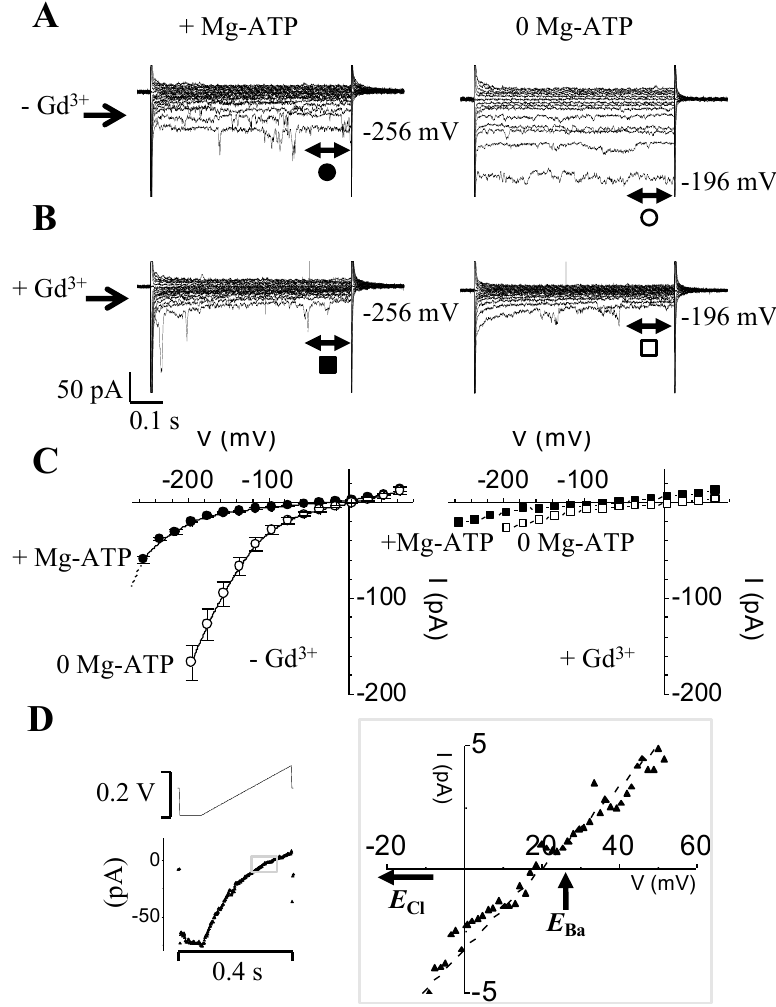
Figure 1. Removal of intracellular Mg-ATP unveils a larger instantaneously-activated, inwardly-directed, and Gd 3 + -sensitive Ba 2 + current. ( A ) Typical examples of current traces in whole-cell mode obtained from two separate V. faba guard cells with the pipette solution either containing (left traces) or lacking (right traces) Mg-ATP (1 mM). The pulse protocol mostly used throughout this study consisted of 0.6 s long square voltage pulses ranging from + 64 to − 256 mV in − 20 mV increments; the holding potential h v was set to − 36 mV. In order to preserve the quality of the “giga” seals, guard cell protoplasts (GCPs) with no Mg-ATP in the pipette were not subjected to higher voltages beyond − 196 mV. ( B ) Current ( I ) traces of I Ba obtained from the same cells and in the same conditions as described in ( A ), except for the external solution containing Gd 3 + (20 mM, left; or 100 mM, right) ( C ) Current–voltage relationships (I-V): left panel, superimposed I-Vs of I Ba in the absence ( ○ ; n = 7) or presence ( ● : n = 3) of Mg-ATP; right panel, I-V relations in the presence of Gd 3+ ( ■ : +Mg-ATP; □ : − Mg-ATP). ( D ) The reversal potential ( E rev ) is close to the reversal potential for Ba 2+ ( E Ba ). Typical current trace recorded in the absence of Mg-ATP (below) in response to a voltage ramp which consists of activating I Ba using a hyperpolarization square pulse to − 156 mV and immediately followed by a continuous depolarizing ramp to +64 mV (the voltage protocol is depicted above), with a slope of 0.7 V s − 1 . Scale bars are shown below the current traces and to the left of the voltage protocol.